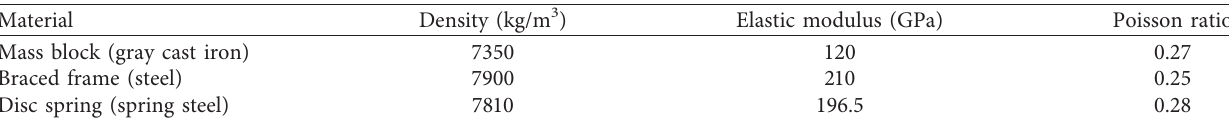
Figure 3: Simulation model of the disc spring Table 1: Material parameters of finite element model.